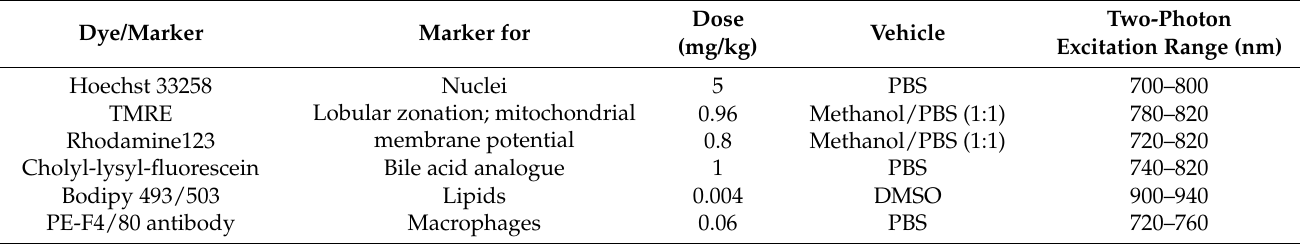
Table 4. Fluorescent markers and functional dyes used for intravital